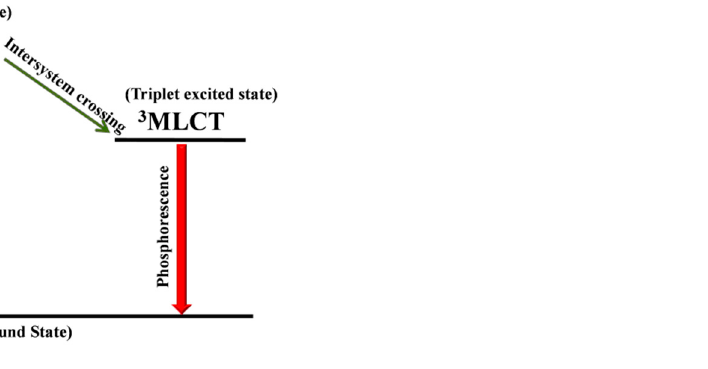
Figure 1. Simplified Jablonski diagram of Ru II /Ir III complexes showing triplet-state emission mech- anism.